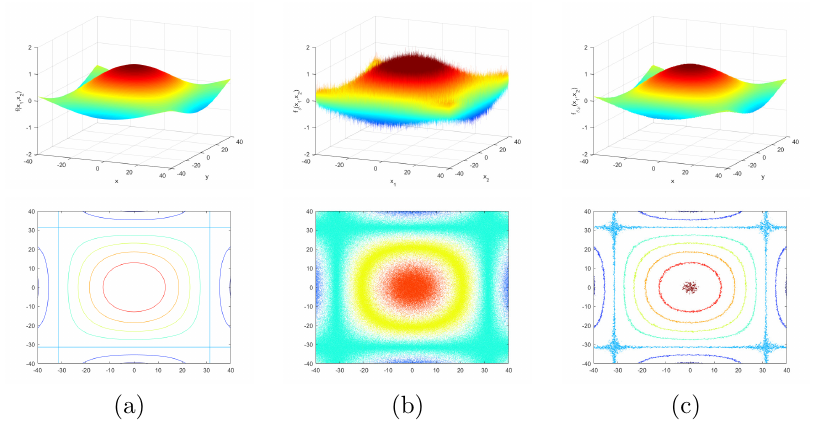
Figure 3. Sources for Example 3: original (a), unregularized (b) and regularized (c) assuming α 2 = 0 . 2 , β = (0 , 0) ,ν = 0 . 999 ,t 0 = 1 ,p = 1 and (cid:15) = 0 .